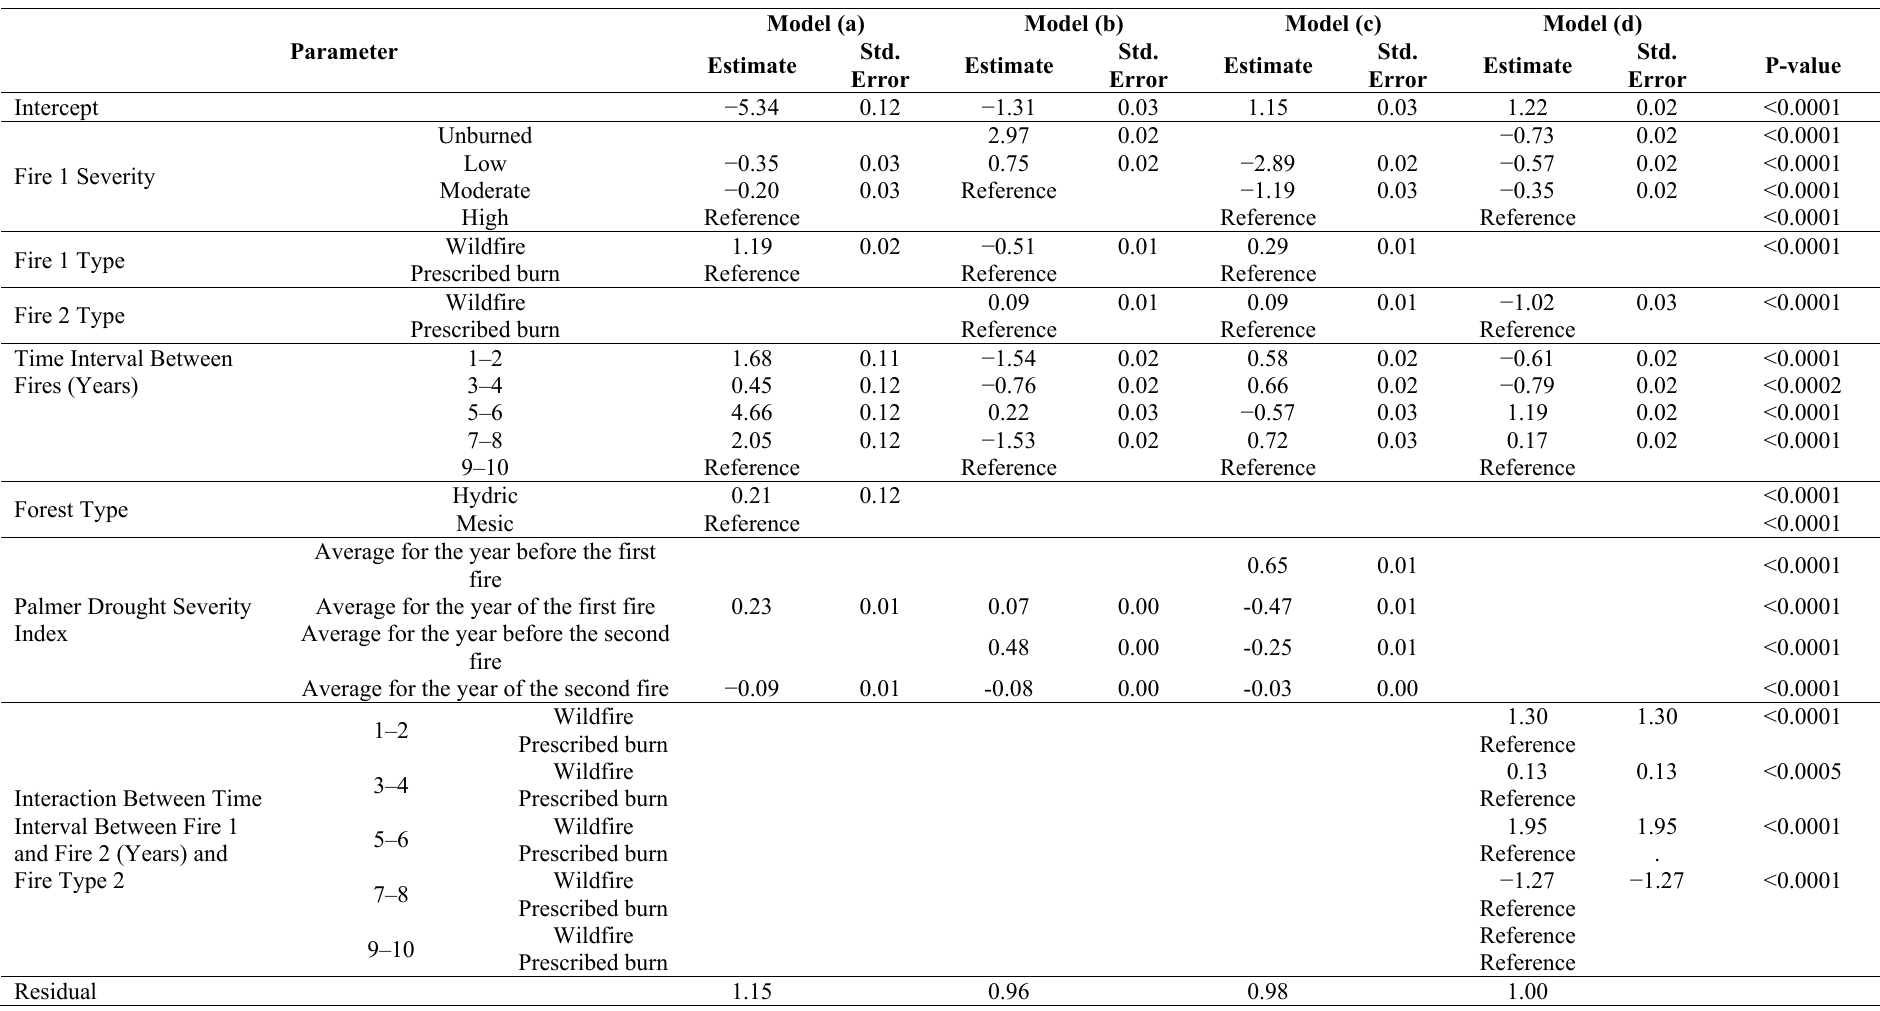
Table 3. Parameter estimates and their respective standard errors, and p-values for the regression models predicting the probability of: ( a ) high burn severity occurrence; ( b ) increasing in burn severity from one fire to the next; ( c ) decreasing in burn severity from one fire to the next; and ( d ) subsequent fire occurrence based on satellite imagery severity classifications from 1998 to